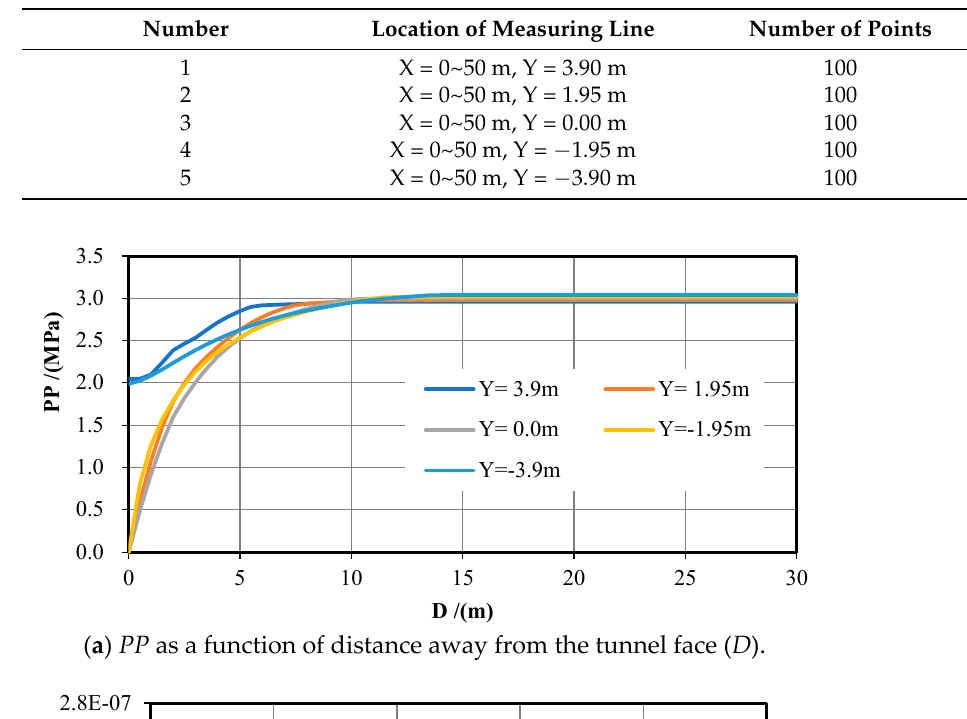
Table 2. Information and location of measuring lines and points.